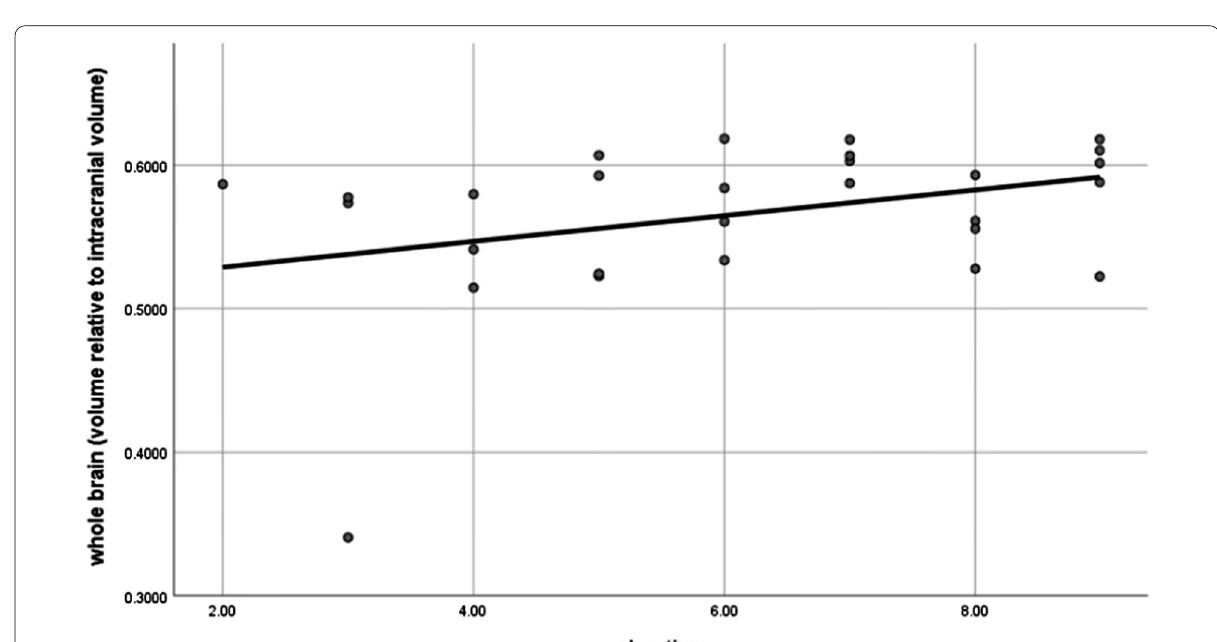
Fig. 19 Relation between loss of whole brain volume and duration of illness in patients with whole brain atrophy